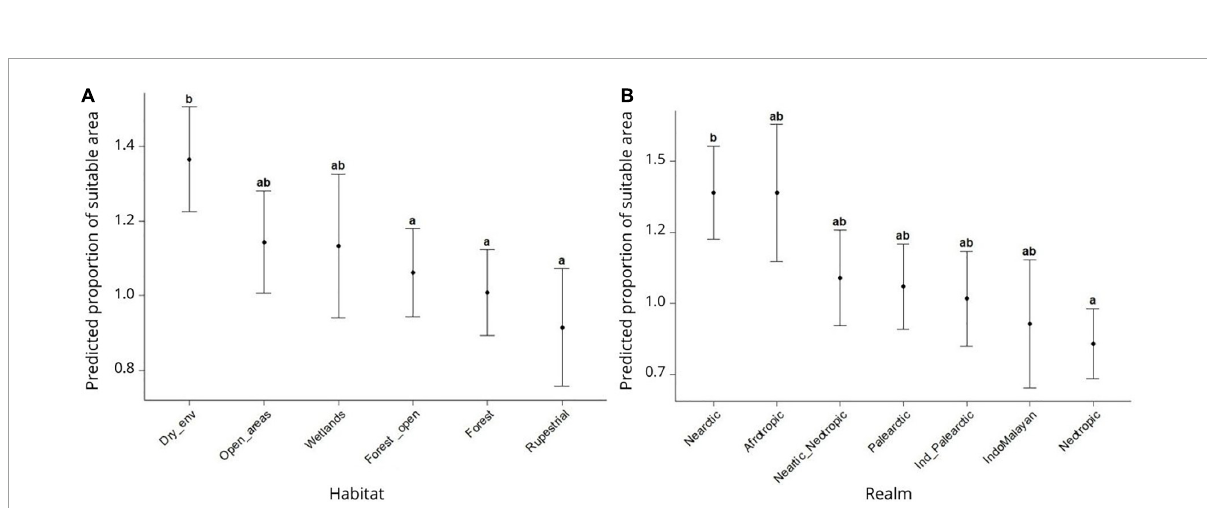
FIGURE4 Estimated marginal means of change in climatically suitable area per habitat type (A) and biogeographical realm (B) . The standard error of the mean is represented by vertical bars. Letters indicate categories with statistically significant